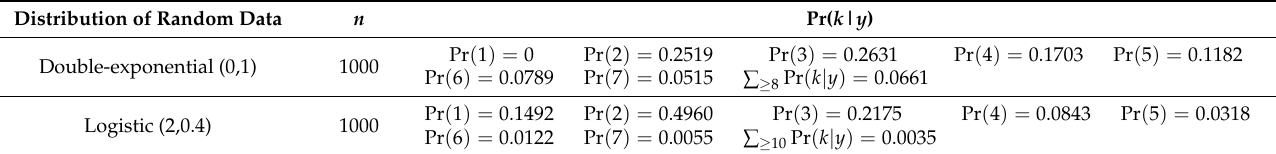
Table 4. Posterior distribution of k for misspecification cases data based on mixture model using the EV-I distribution. Distribution of Random Data n